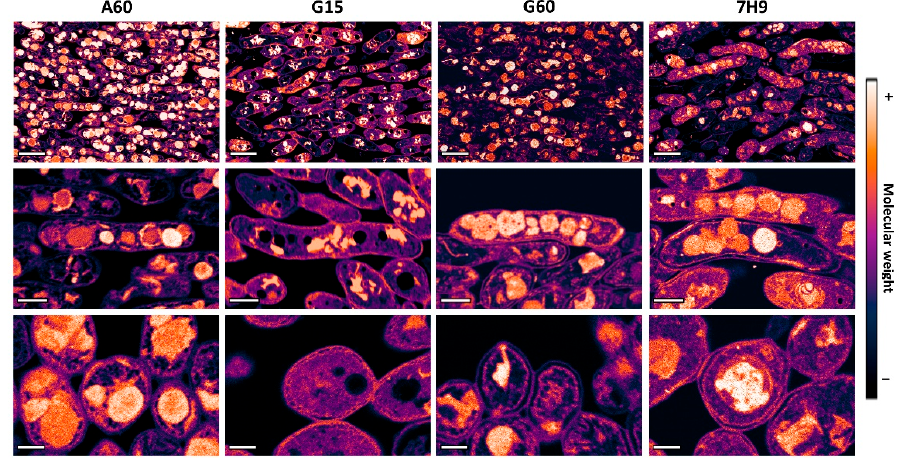
Figure 3. Unsaturated lipids distribution in M. brumae cells of mature pellicles grown in the different culture media. Representative FESEM BSE images in pseudocolour showing an overview of cells and details of longitudinal and transversal sections of bacterial cells. Scale bars correspond to 1 µm in general view images, 200 nm in longitudinal and 300 nm in transversal sections of bacilli. Sauton A60, G15, and G60 media, or Middlebrook 7H9 medium were used to culture mycobacteria. A60 is Sauton containing L-asparagine and 60 mL/L of glycerol (6% v / v ). Sauton G15 and G60 contained L-glutamate and 15 or 60 mL/L of glycerol (1.5% and 6% v / v ), respectively.